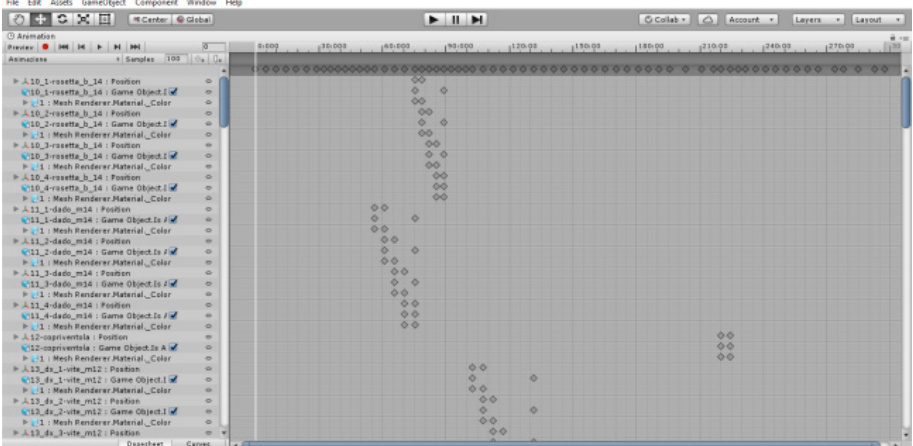
Figure 31. Gearbox animation with Unity (scale 1:1).